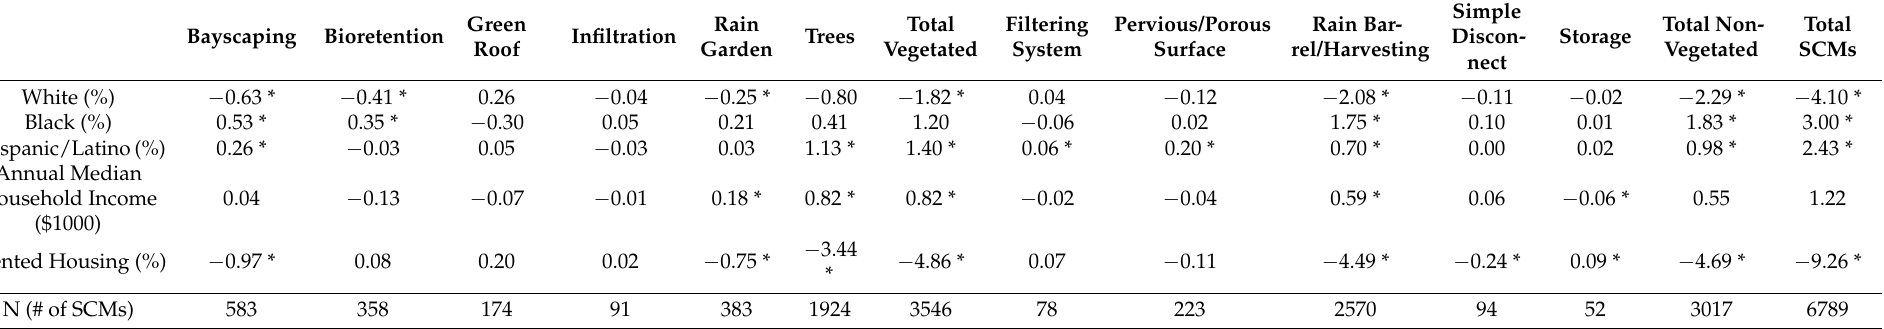
Table 1. Change in SCM installation density (SCM count per km 2 ) in 2014 per interquartile range (IQR) increase of pre-installation socio-demographics variables. Green Bayscaping Bioretention